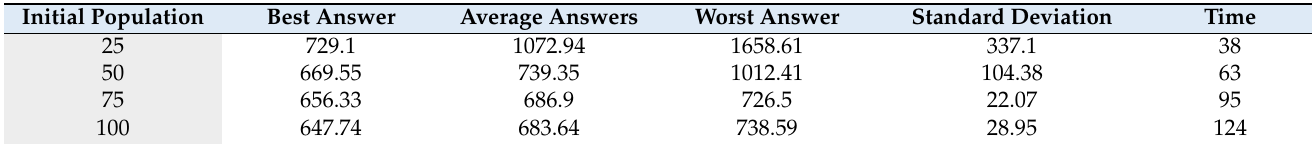
Table 20. The results of implementing the proposed algorithm with different initial populations with the aim of reducing costs.